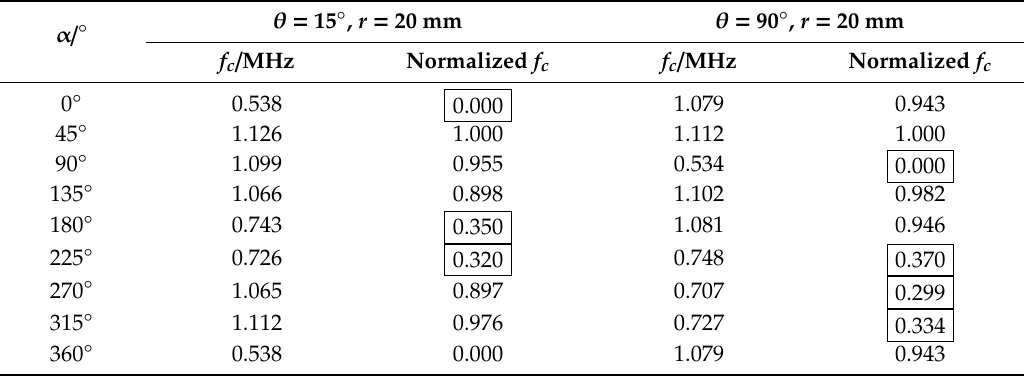
Table 4. The measured f c (MHz) and normalized values between E1 and